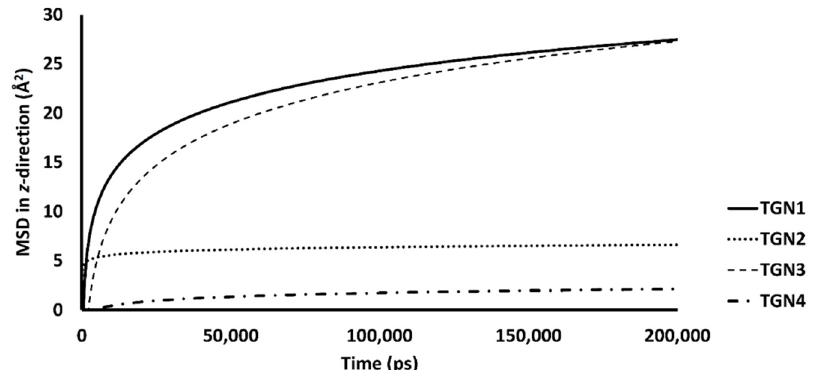
Figure 6. The mobilities in the z -direction of TGN1, TGN2, TGN3, and TGN4 in the POPC membranes are shown as the logarithmic nonlinearity of MSD on the ps timescale.